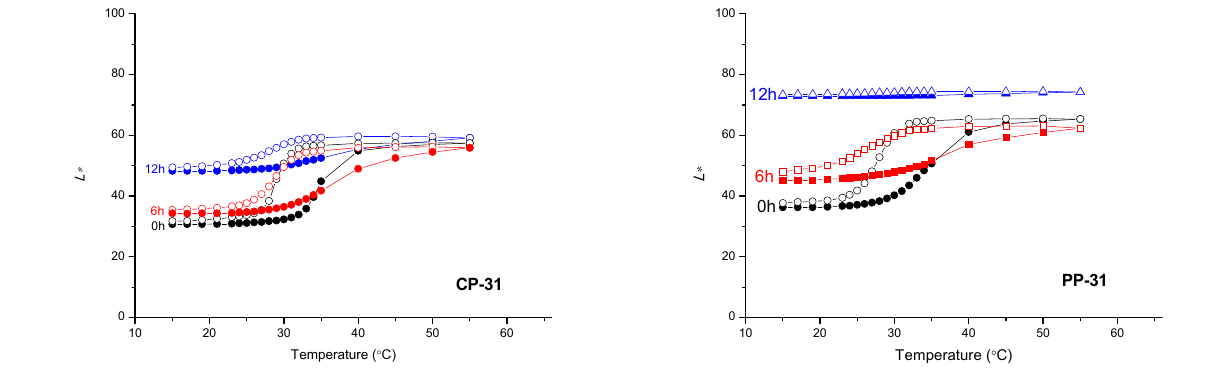
Figure 7. CIELAB lightness L * of CTI45 sample in dependence on the temperature at heating (solid signs) and cooling (open signs) on both substrates.